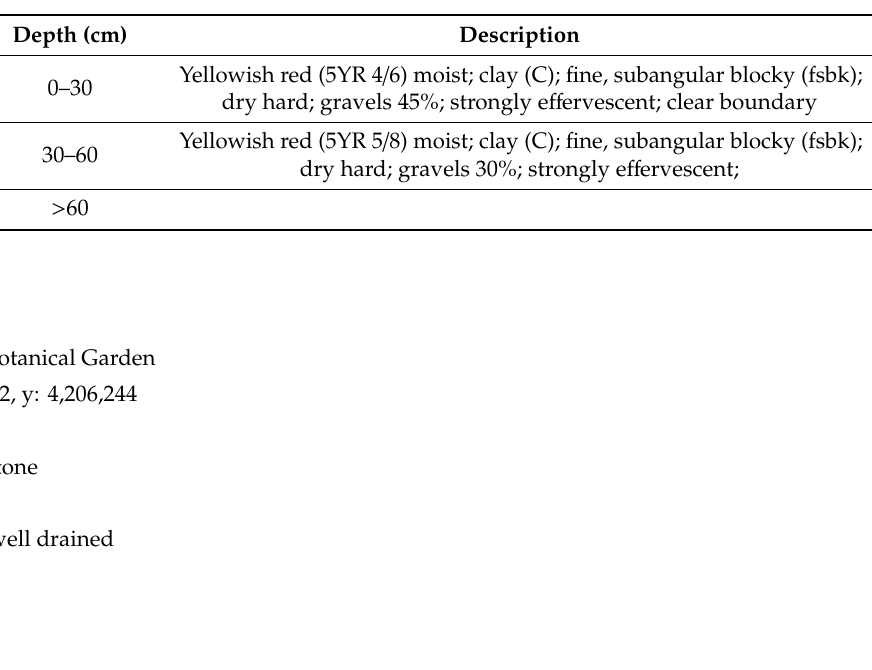
Table A21. Profile P2 horizons